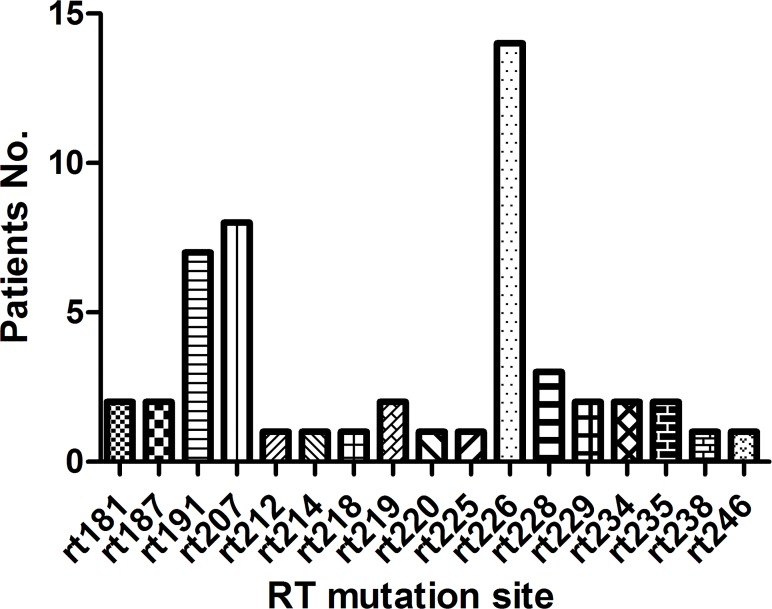
Distribution of pre-existing mutations in HBV RT region of 43 samples.